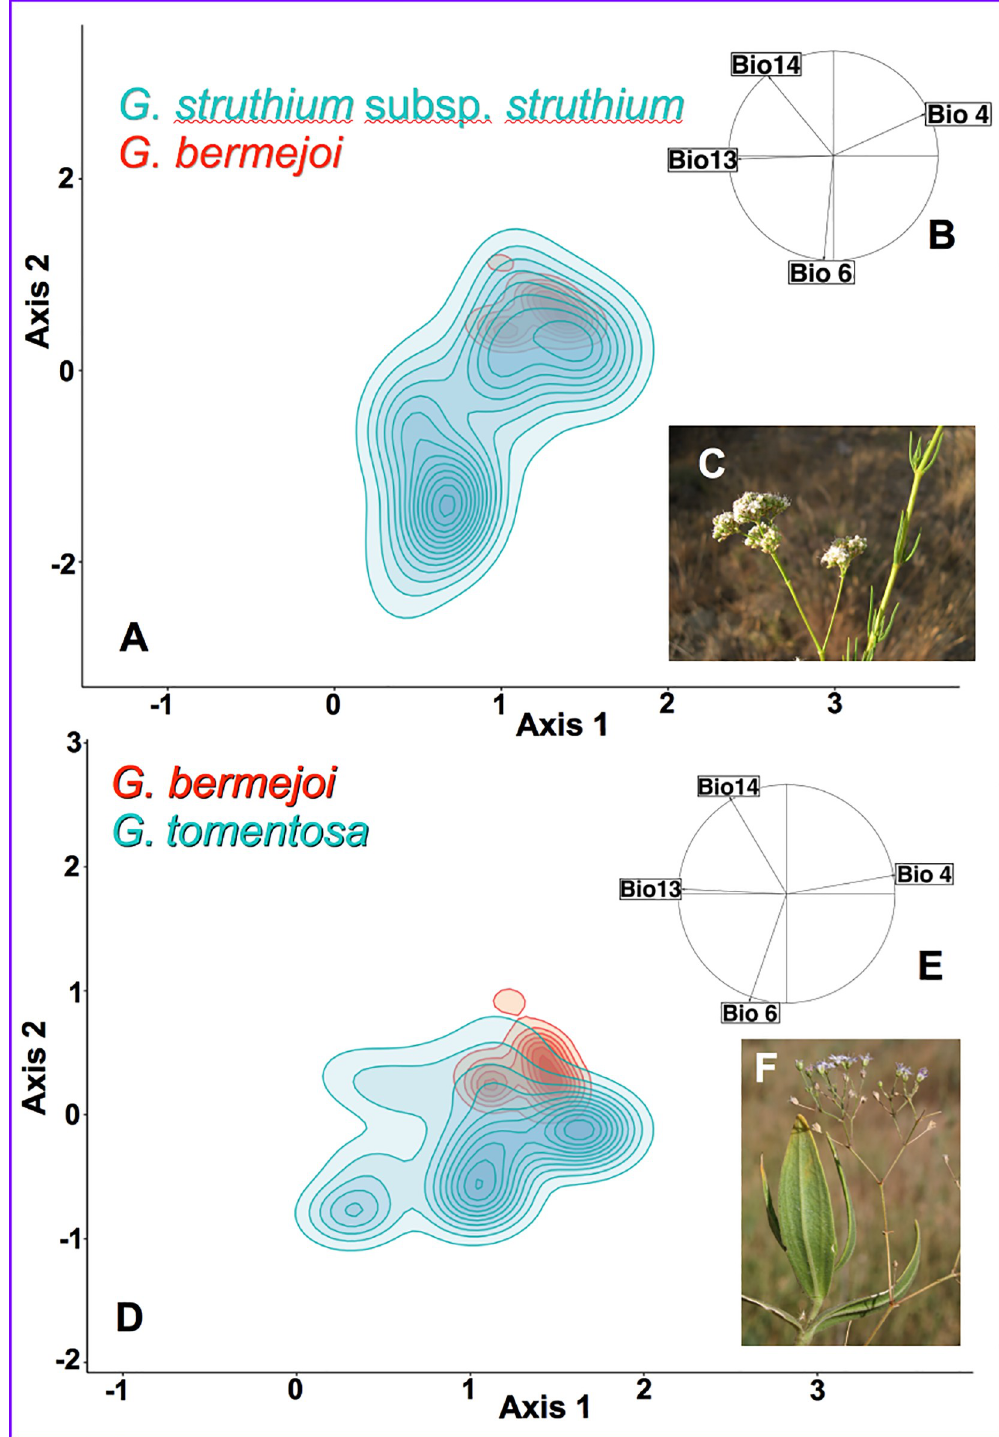
Fig 6. Bioclimatic niches of G . bermejoi and its parental species ( A and D ). The environmental space is defined by the first two axes of the PCA analysis, and it is limited by the minimum and maximum environmental values in the whole study area. The different taxa have been plotted in pairs to make comparisons easier: ( A ) G . bermejoi (red) vs. G . struthium subsp. struthium (blue); ( D ) G . bermejoi (red) vs. G tomentosa ). Note that G . bermejoi has a narrower niche in both cases. B and E show the correlation circles for the variables used in the PCAs. The appearance of the parental taxa of G . bermejoi is shown in C ( G . struthium subsp. struthium ) and F ( G . tomentosa ). https://doi.org/10.1371/journal.pone.0218160.g006 PLOS ONE | https://doi.org/10.1371/journal.pone.0218160 June 13,